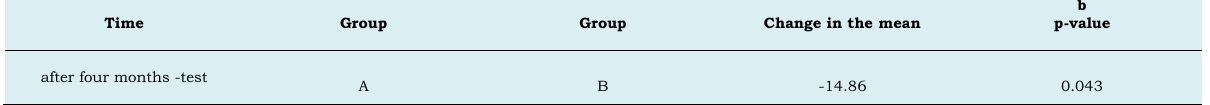
Table 3 LDL (mg/dl) differences between the A and B groups after four